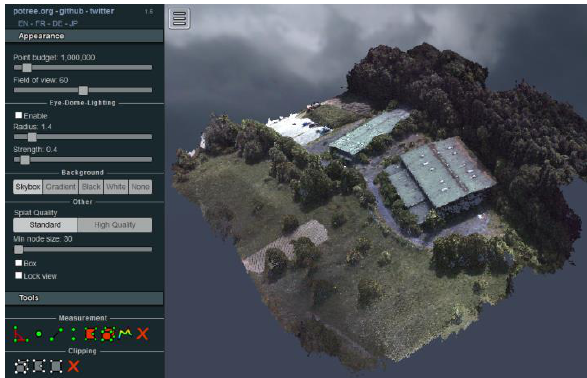
Figure 19: 3D rendering of large point cloud generated of the studied area using Potree Converter